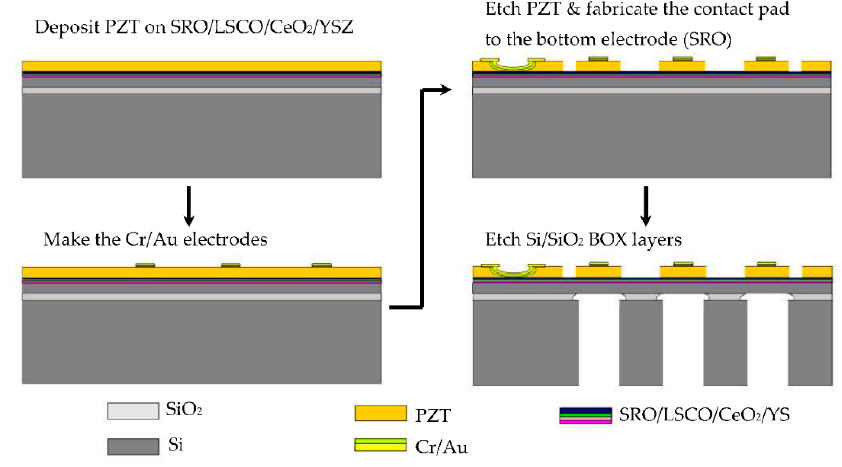
Figure 2. Process chart of pMUT array based on PZT thin film.